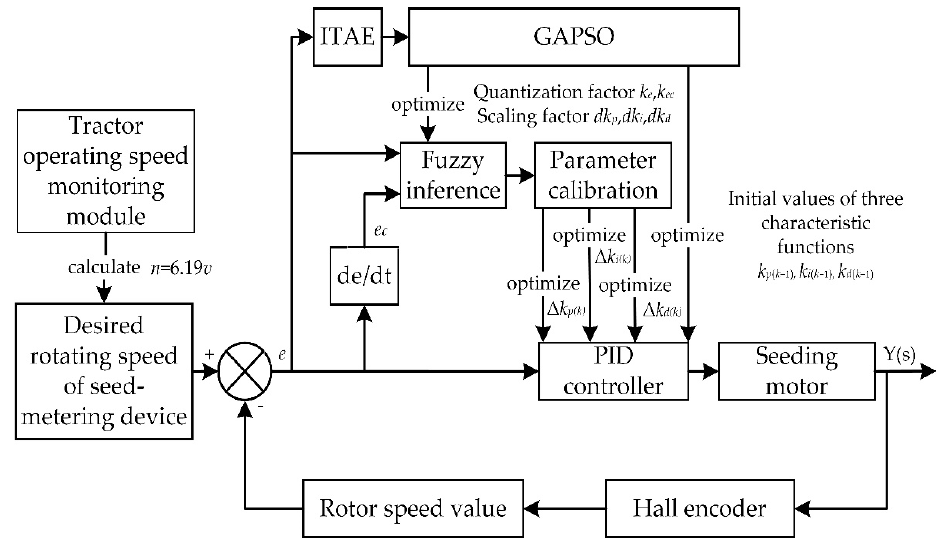
Figure 5. Flowchart of GAPSO-optimized fuzzy PID controller for EDS.